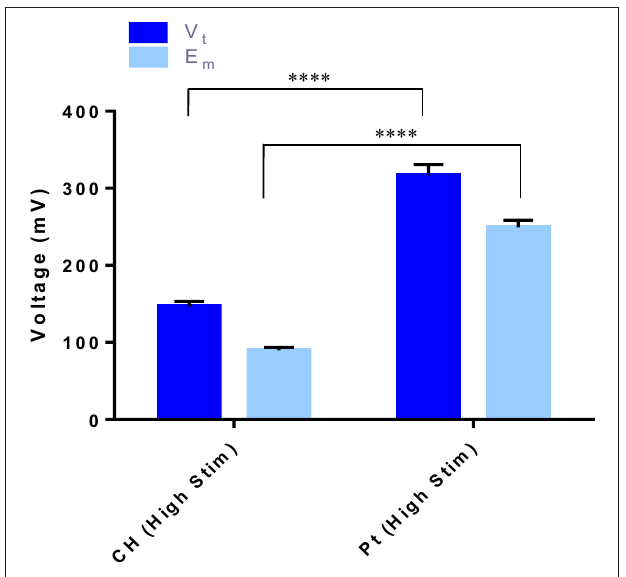
FIGURE 3 | The total voltage (V t ) and the residual voltage (E m ) at the of the cathodic phase for both the CH and Pt electrode systems. Error bars represent one standard deviation. ( t -test, ****significant difference, p ≤ 0.0001, n = 3).